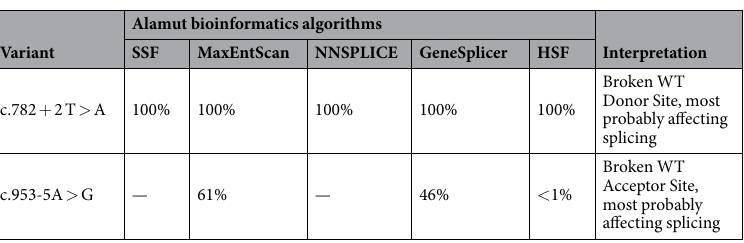
Table 3. Splice site mutation predictions with the usage of Alamut bioinformatics algorithms. SSF- SpliceSiteFinder-like; HSF- Human Splicing Finder; – no data.